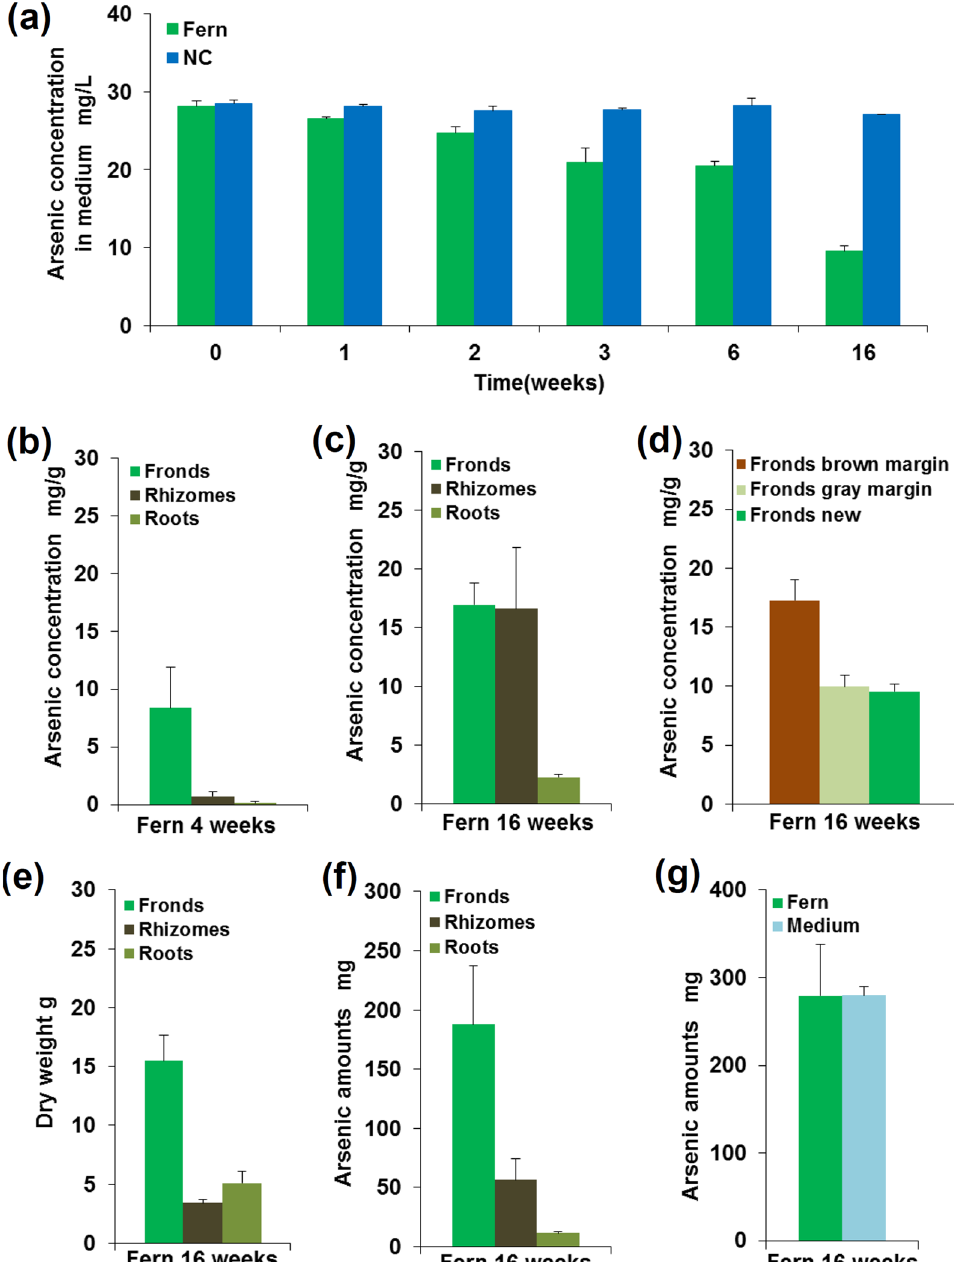
Figure 1. As phytofiltration experiment with P . vittata over 16 weeks. ( a ) Time course of As removal in medium with P . vittata (Fern) and without P . vittata (NC) over 16 weeks. After 4 weeks As phytofiltration experiment, ( b ) As concentration in fronds, rhizomes and roots of P . vittata . After 16 weeks As phytofiltration experiment, ( c ) As concentration in fronds, rhizomes and roots of P . vittata . ( d ) As concentration in different stages of fronds (fronds brown margin, fronds gray margin, fronds new) of P . vittata . ( e ) The dry weight of fronds, rhizomes and roots of P . vittata . ( f ) As amounts in fronds, rhizomes and roots of P . vittata . ( g ) As mass balance between As uptake by P . vittata and As decline from the medium. Data are expressed as mean + standard deviation (n =